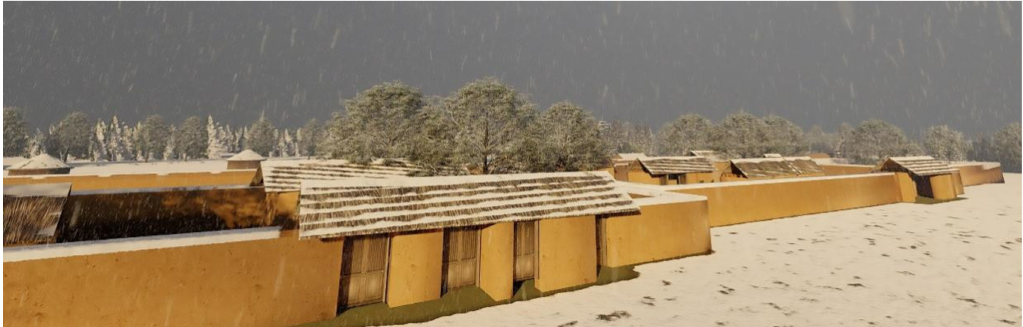
Figure 19. Snowscape at the SHS